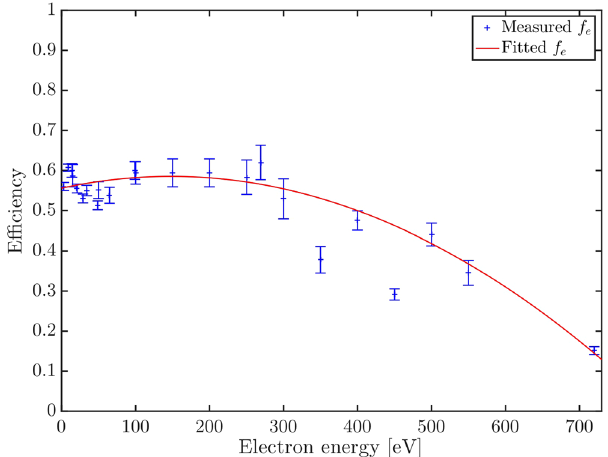
Figure 3. Combined collection-detection efficiency of the magnetic bottle electron spectrometer used in the present study as a function of electron kinetic energy. Error bars display the standard deviation for the efficiency in each data